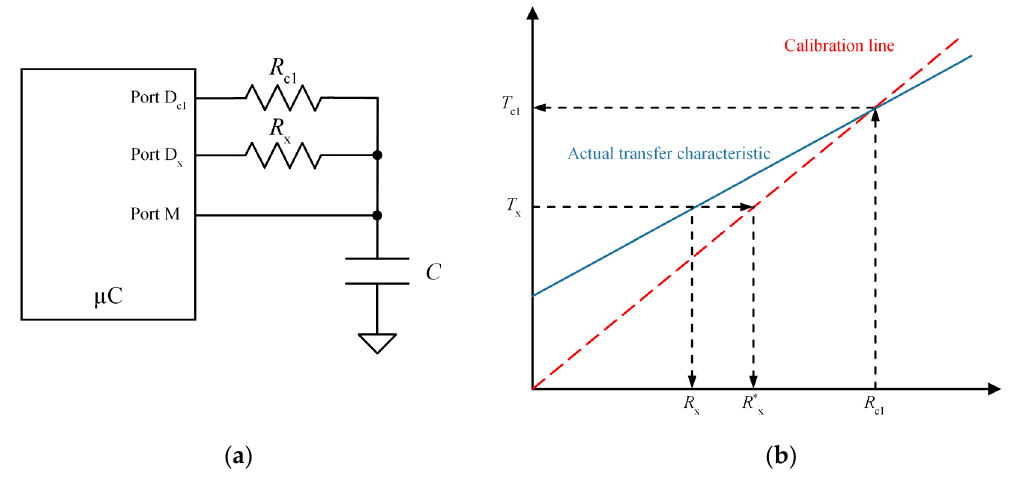
Figure 2. Single point calibration: ( a ) circuit and ( b ) actual and calibration transfer characteristics.